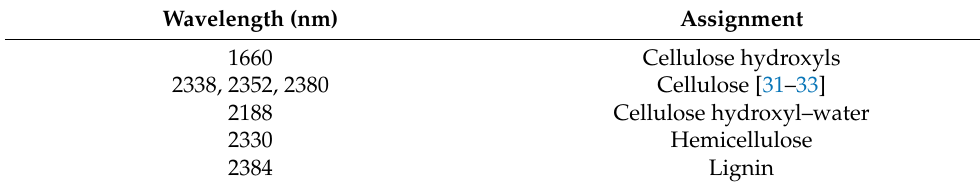
Table 3. The band assignment of these selected